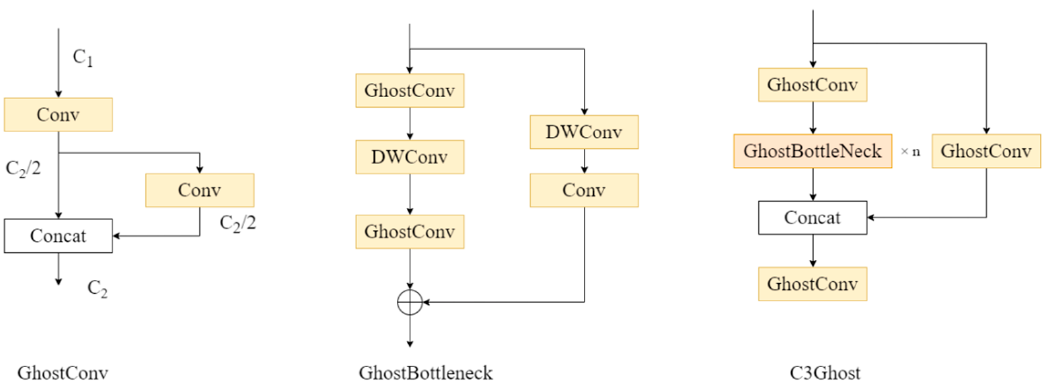
Figure 4. Main structure of YOLOv5 with GhostNet.